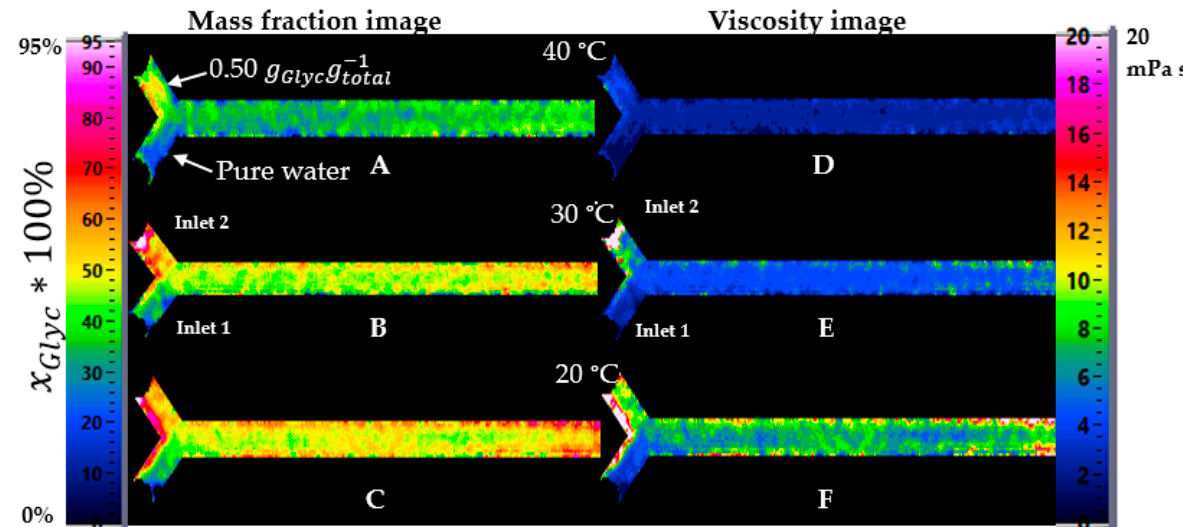
Figure 11. Effect of the temperature on the concentration in mass fraction mapping from channel at 40, 30, and 20 ◦ C ( A – C ) for a slight difference of viscosity between inlet 1 water and inlet 2 with 0.50 g Glyc g − 1 . ( D – F ) Viscosity mapping from channel at these three temperatures.